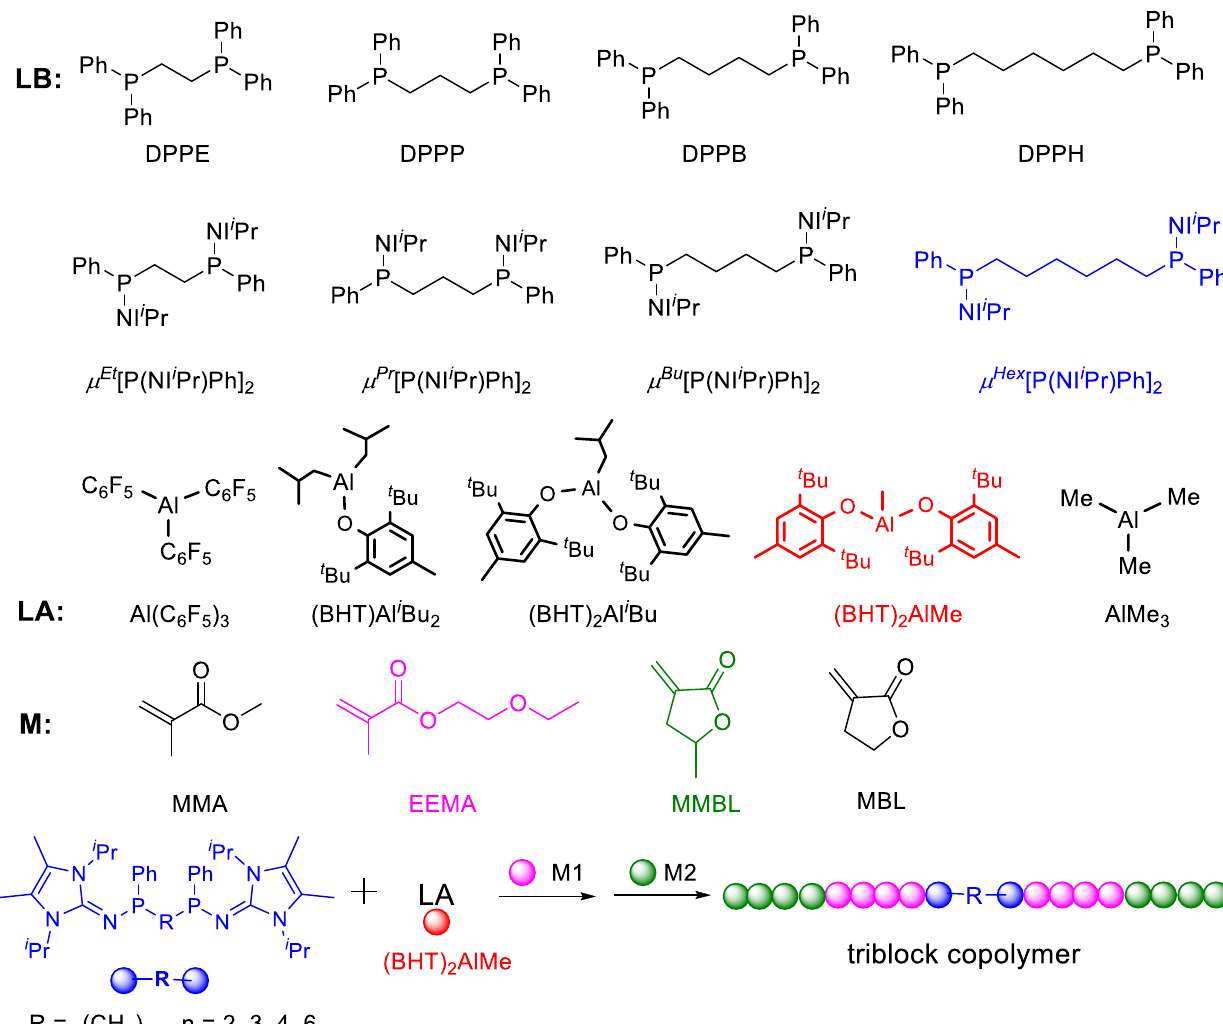
Fig. 1 Structures and synthetic process. The chemical structures of Lewis base (LB), Lewis acid (LA), and monomer (M) investigated in this study. Bottom: outlined synthesis of tri-BCPs in a one-pot, two-step